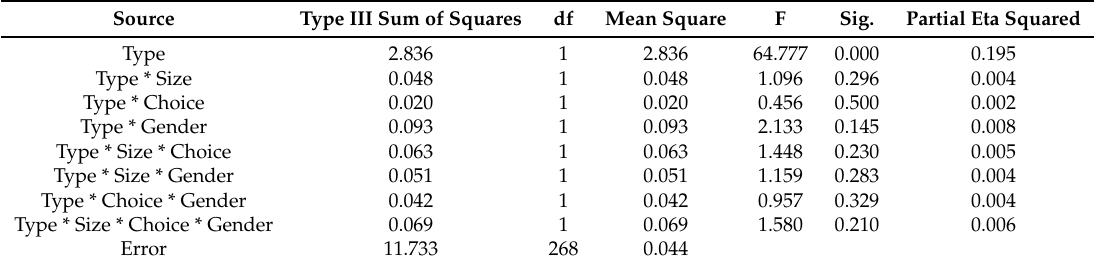
Table 7. Tests of within-subject effects for type of problem in respect of size, choice and